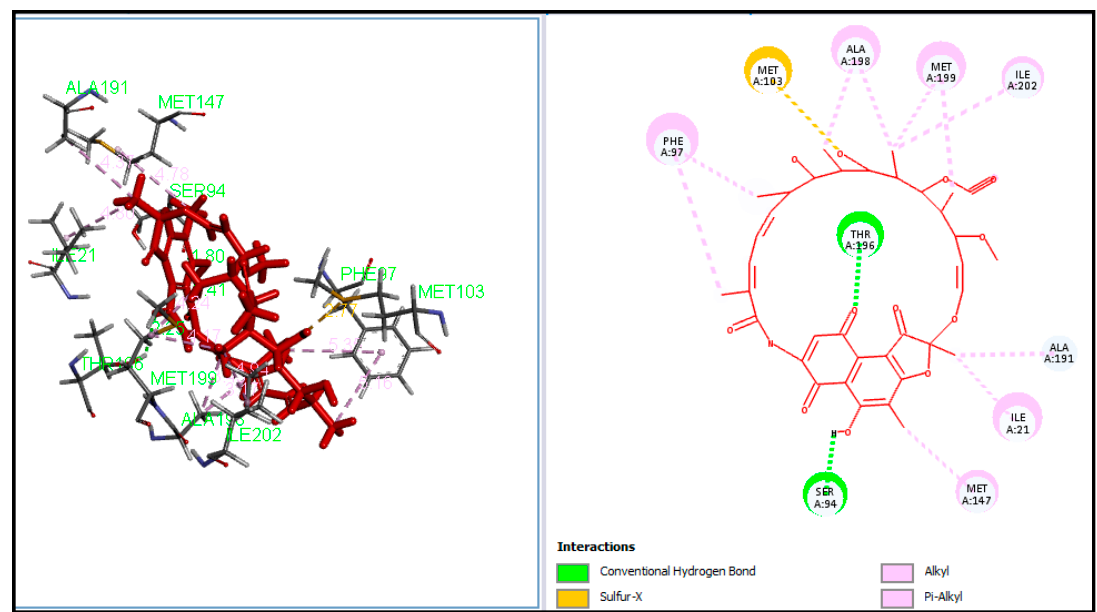
Figure 5. Binding Pose and molecular interactions of Rifampicin into the active site of InhA.